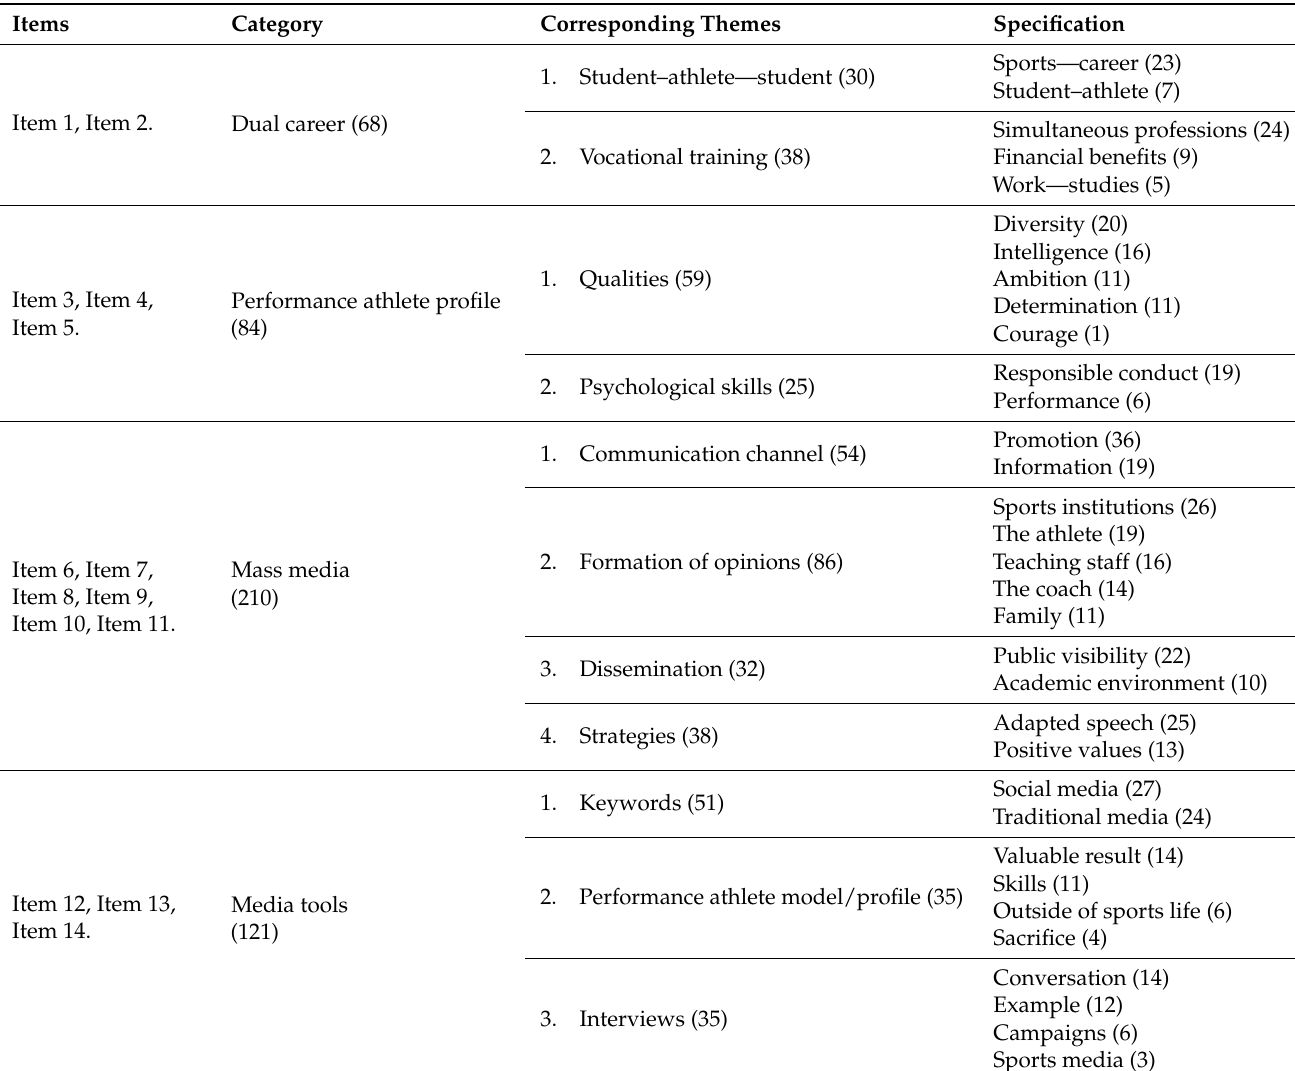
Table 2. Analysis of the distribution of themes and specifications at interview